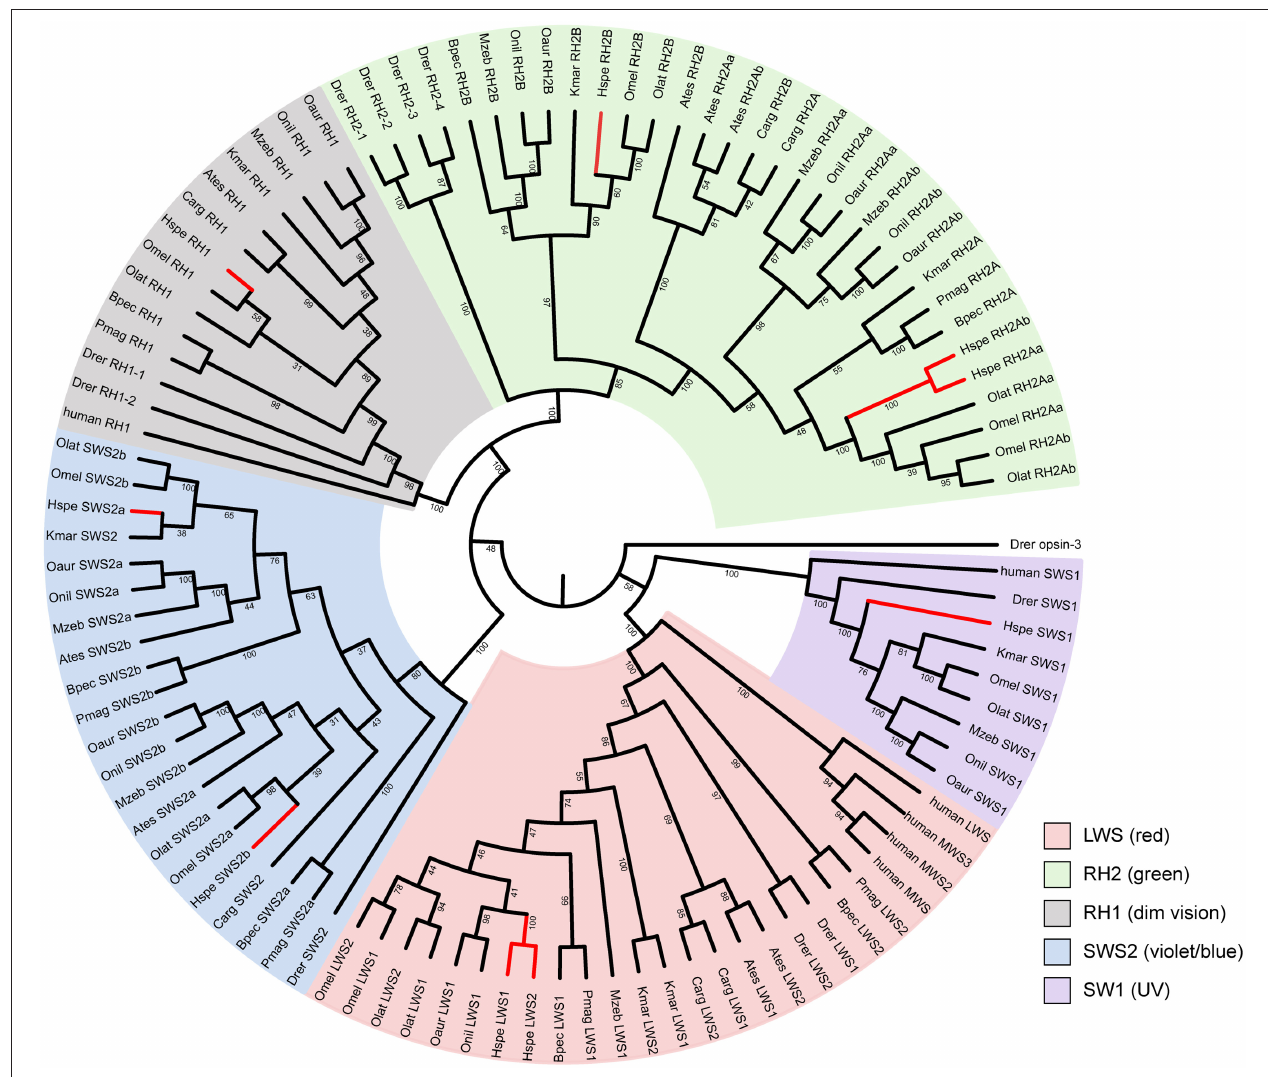
FIGURE 2 | The phylogenetic tree of vertebrate opsin genes. A rooted neighbor-joining (NJ) tree was constructed with zebrafish opsin3 as the outgroup. Abbreviations are provided in Supplementary Table 1 .